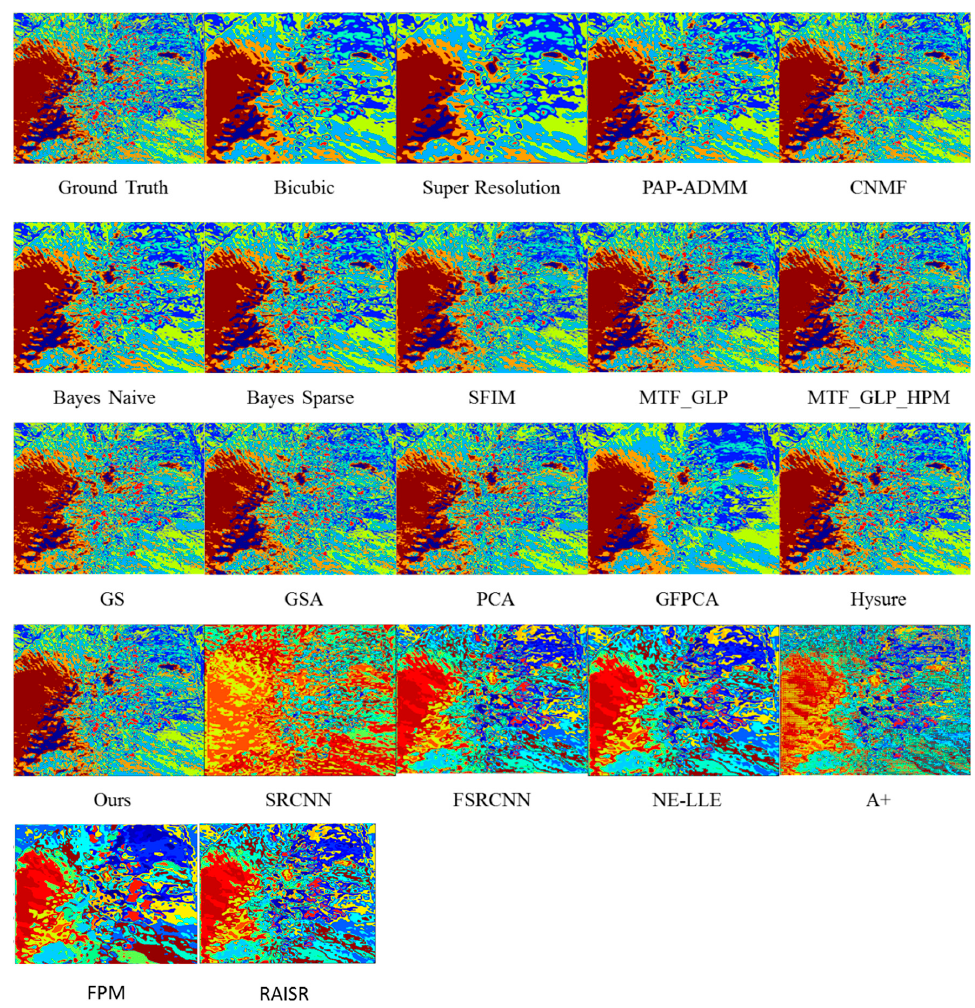
Figure 15. Cluster maps of different algorithms for the AVIRIS data.